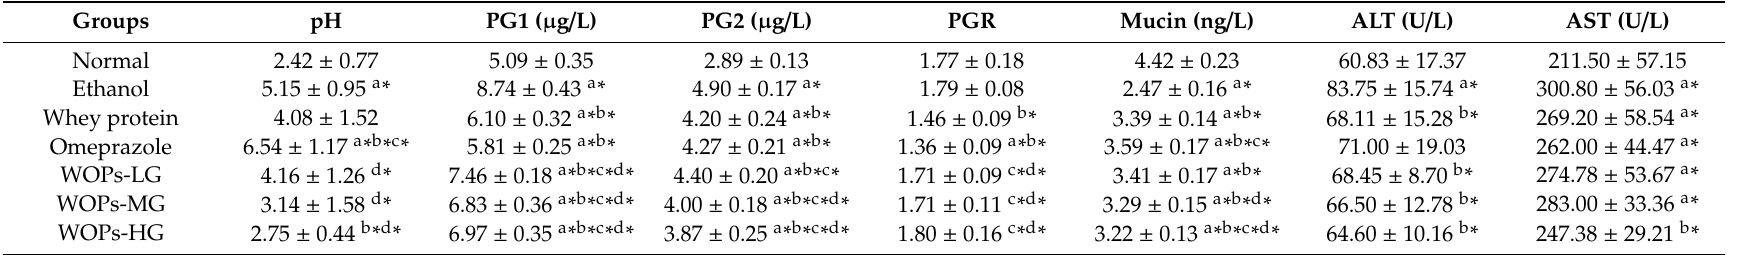
Table 3. E ff ect of WOPs on gastric content pH, pepsinogen, gastric mucin and serum ALT, AST